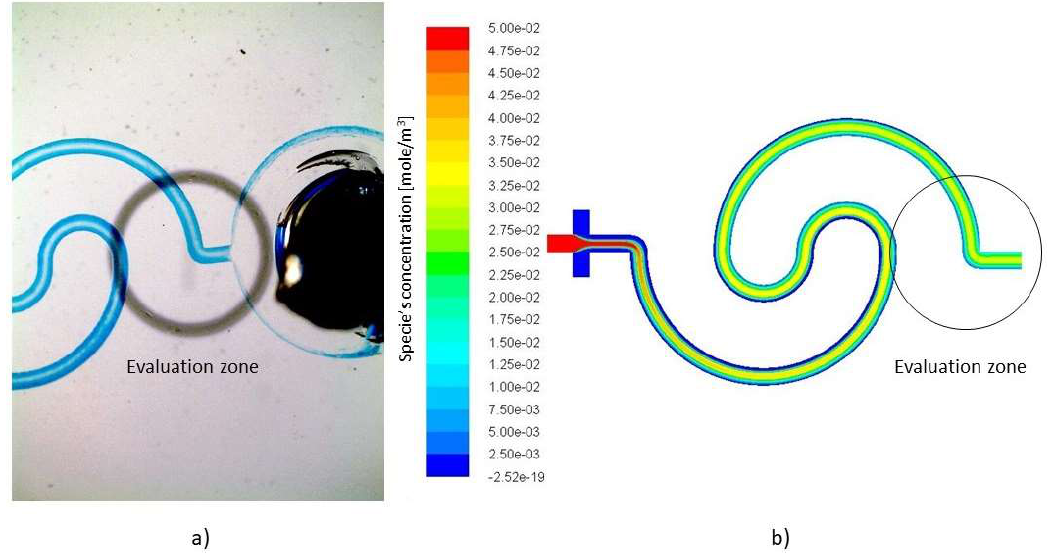
Figure 7. One loop simple spiral mixer: ( a ) Manufactured device species concentration, ( b ) Numerical simulation of the species concentration.